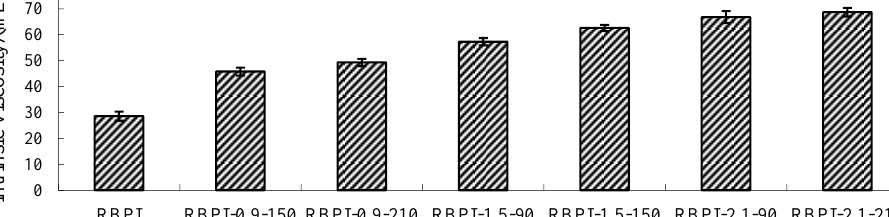
Figure 2. Intrinsic viscosity of RBPI prepared from different SFE pretreatment conditions.